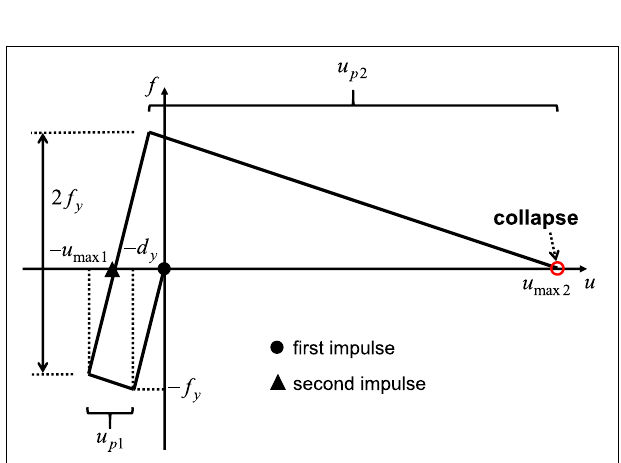
FIGURE 5 | Definition of plastic deformations after the first and second impulses and characterization of collapse of structure